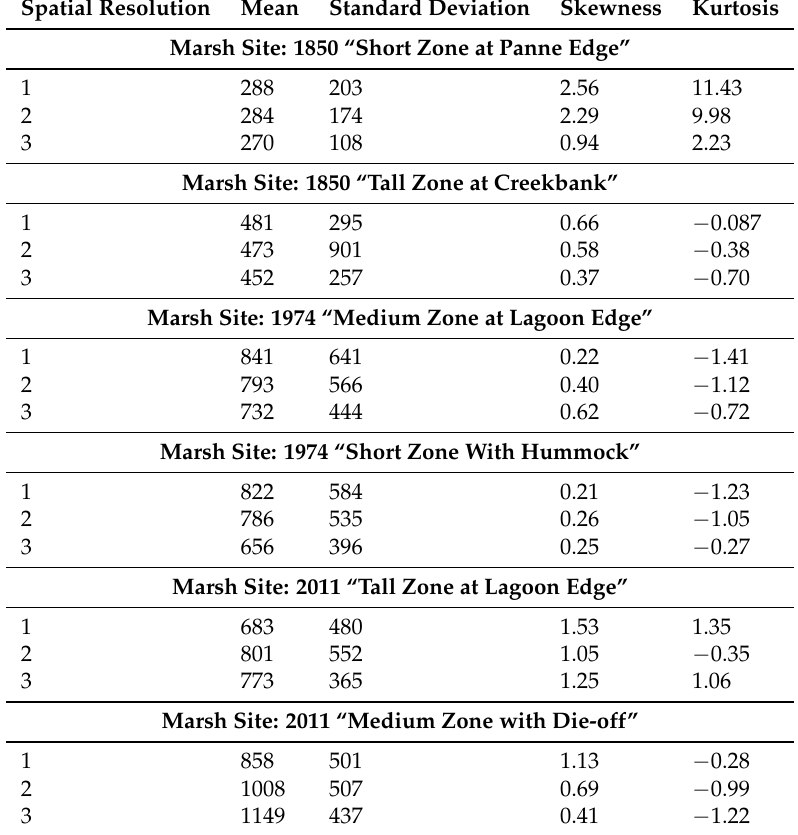
Table 2. The mean, standard deviation, skewness and kurtosis for the ROIs shown in Figures 6 and 7. The spatial resolution “1” is the original resolution, “2” the resolution was changed by a factor of four, and “3” by a factor of hundred. Spatial Resolution Mean Standard Deviation Skewness